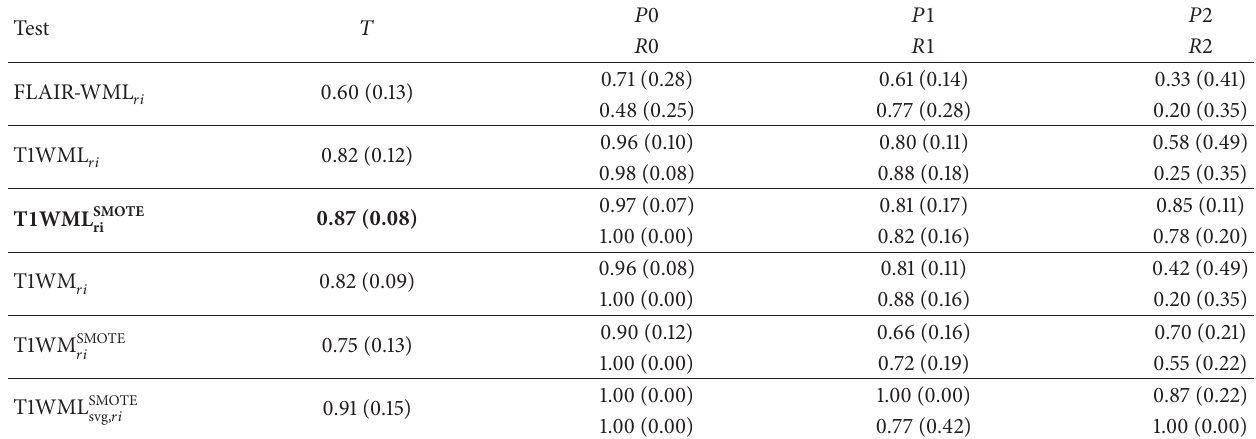
Figure 5: Nested cross validation: in the inner loop, the performance of different sets of classifier parameters and features is estimated based on a bootstrap cross validation. The optimal classifier parameters and features are selected based on the performance evaluation over several bootstrap rounds. In the outer loop, model performance of the optimized classifier parameters and features is evaluated on the hold-out test set in the outer loop. The outer loop is repeated several times, every time with potentially different classifier parameters and features. Table 2: Results are reported as mean with standard deviation in brackets, 𝑚 ( 𝑠 ), over 10-fold cross validation, classifying NC versus AD versus LBD. 𝑇 = total accuracy, 𝑅 = recall, and 𝑃 = precision. 0 for class NC, 1 for class AD, and 2 for class LBD. ROI is either WM for white matter or WML for white matter lesion